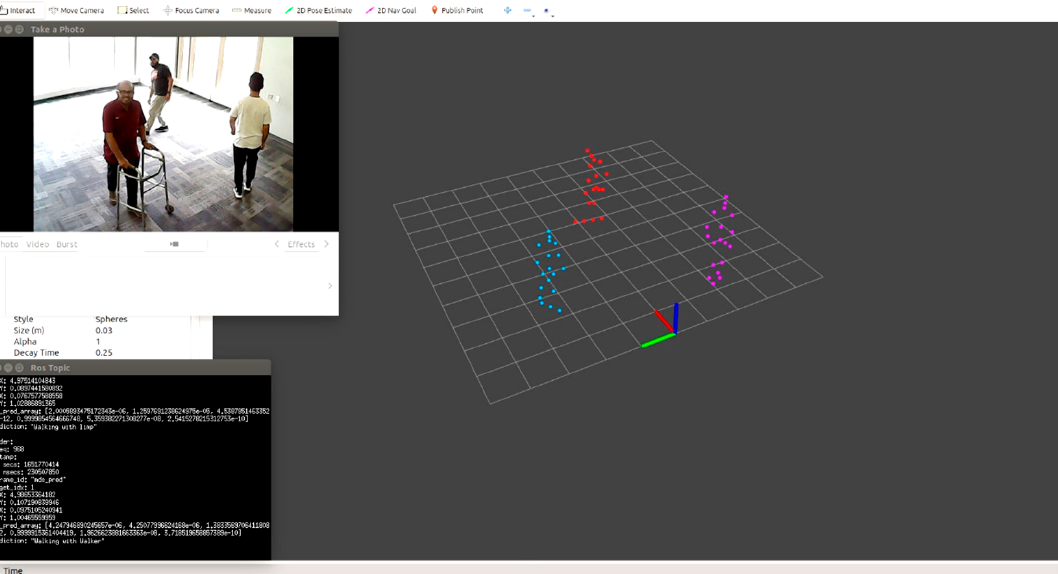
Figure 20. Three subjects, one walking with a walker, one walking normally, and one limping.